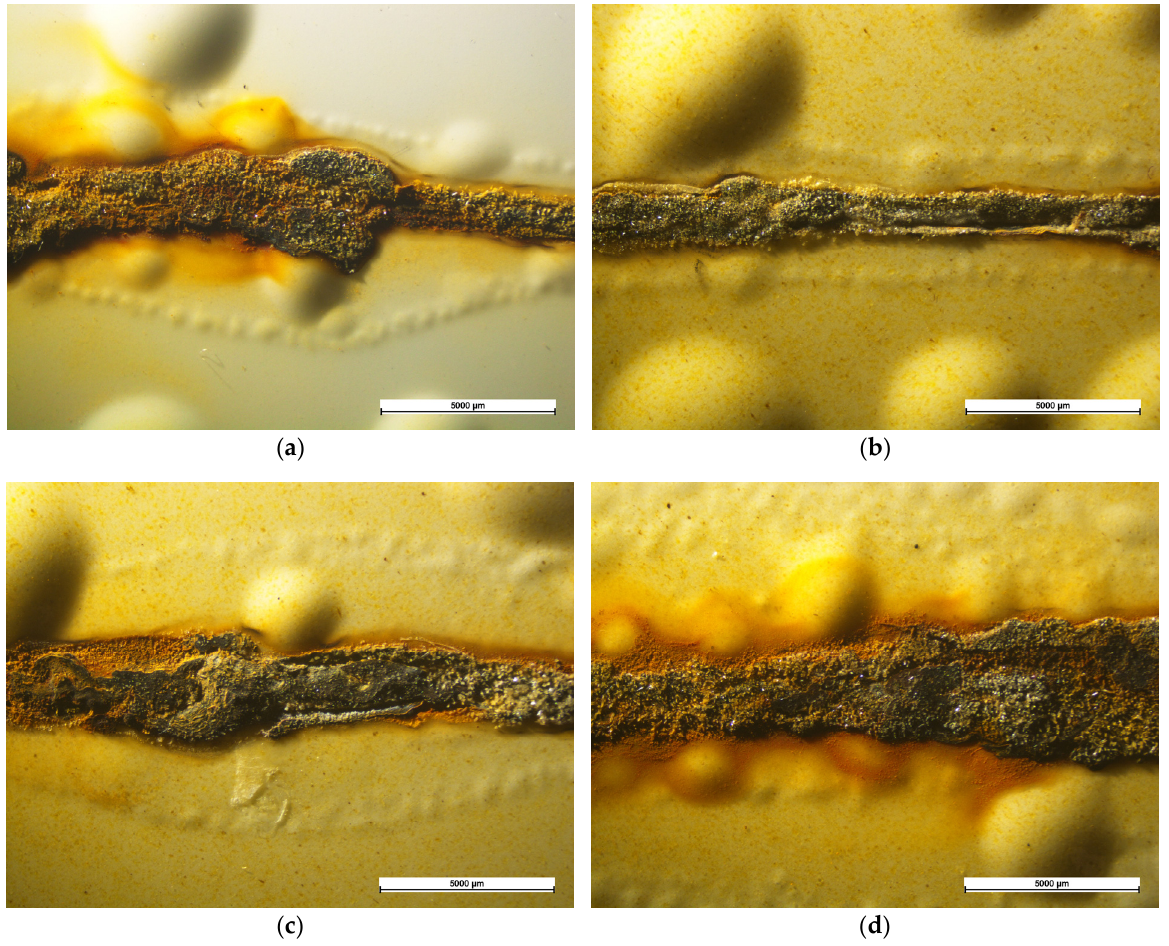
Figure 7. Cathodic delamination at the artificial notch of ( a ) sample T, ( b ) sample O, ( c ) sample S, and ( d ) sample W, after 500 h of exposure in the salt spray chamber.